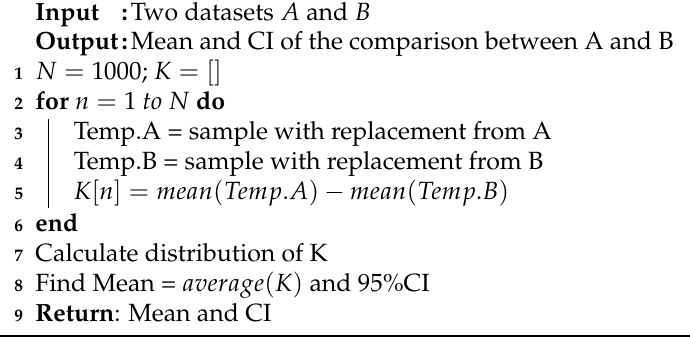
Algorithm 1: Bootstrap technique to find the mean and 95% confidence interval (CI) of a